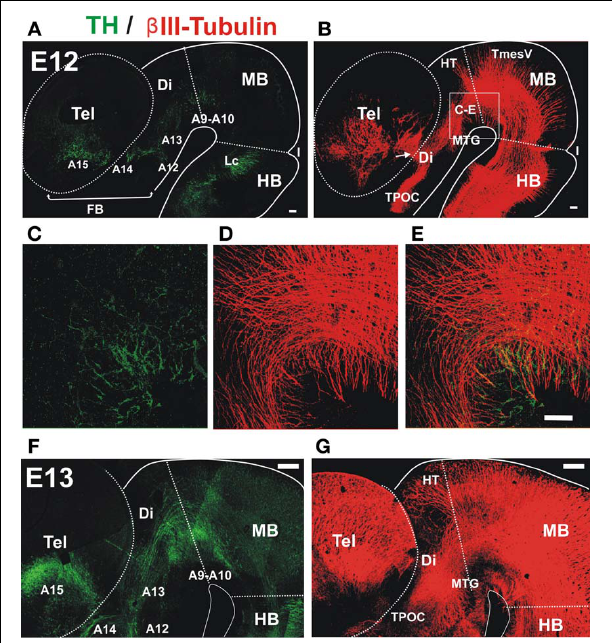
FIGURE 1 | Early projecting midbrain TH axons grow into territories containing pre-existing non-dopaminergic axon bundles. Whole brains from E12 (A–E) and E13 (F,G) rat embryos were immunostained, cut along dorsal and ventral midlines and the resulting hemibrains were mounted flat. Confocal images were collected and are shown here as projections of Z-stacks. (A,C,E,F) Tyrosine Hydroxylase (TH, green) immunostaining. Approximate location of dopaminergic cell groups is indicated from A9 to A15. (B,D,E,G) β III-Tubulin-stained fiber tracts (red). (C–E) Show a magnified view of a field in the ventral MB region and part of the diencephalon (Di) indicated in (B) . Arrow in (B) indicates the point of entry of TH axons into the striatal anlage. Abbreviations: Tel, Telencephalon; Di, Diencephalon; I, Isthmus; HB, hindbrain; MB, midbrain; Lc, locus ceruleus; TPOC, tract of the post-optic commissure; HT, habenular tract; MTG, mammillotegmental tract; TmesV, mesencephalic nucleus of the trigeminal nerve. Scale bar: 100 μ m.